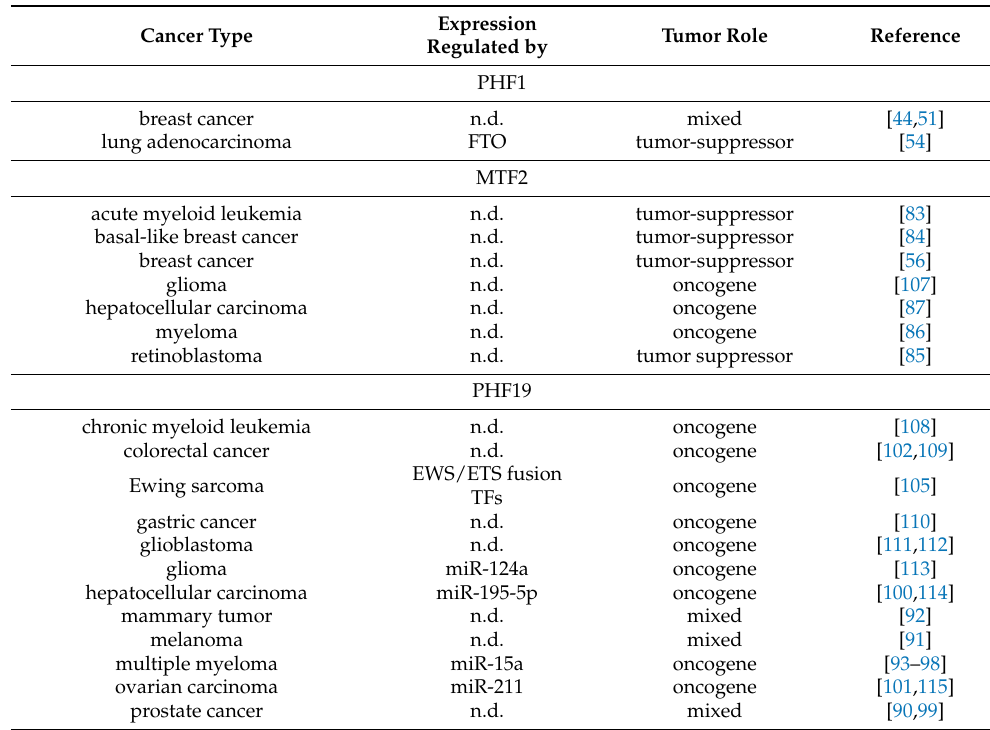
Table 2. Roles of the PCLs in